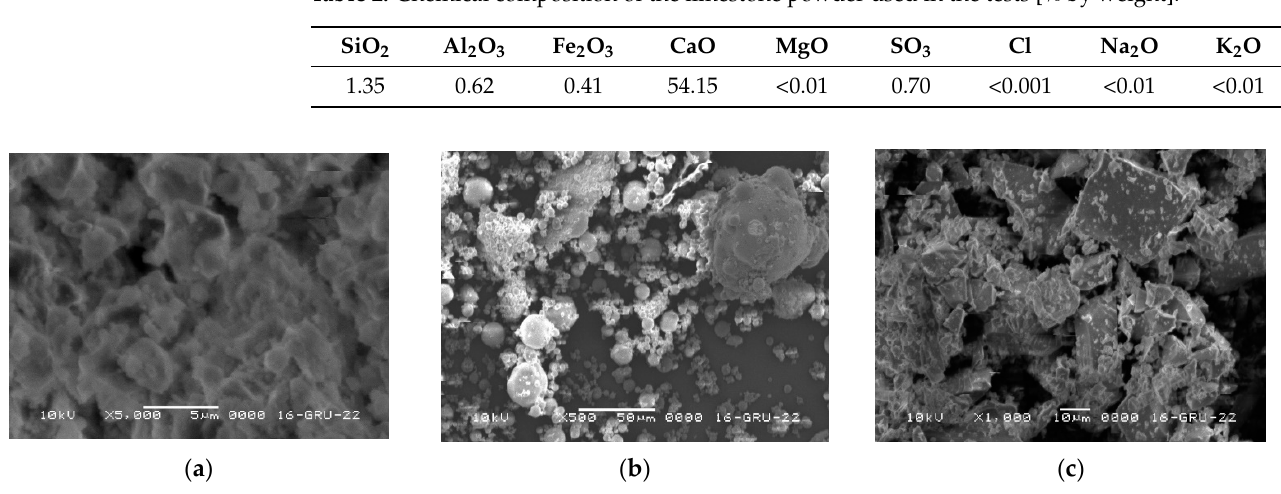
Table 3. Chemical composition of the silica fly ash used in the tests [% by weight].